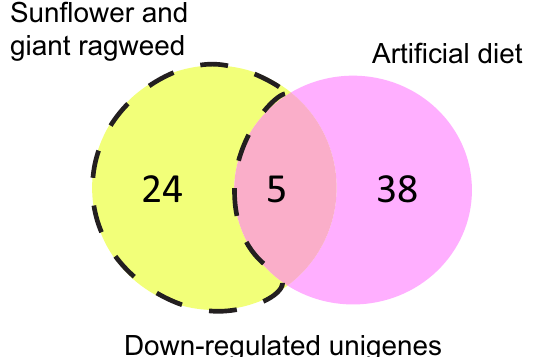
Figure 5. Expression profiles of down-regulated unigenes in Dectes texanus larvae fed different diet treatments ( A ) Unigenes with lower expression levels in larvae fed soybean compared to those fed sunflower and giant ragweed ( B ) Unigenes with lower expression levels in larvae fed soybean compared to those fed artificial diet and ( C ) Venn diagram of downregulated unigenes in larvae fed soybean compared to those fed sunflower, giant ragweed, and artificial diet. Clusters were constructed with differentially expressed genes showing similar expression patterns across all treatments (Fold change > ± 1.5, False Discovery Rate < 0.05) GR = Giant